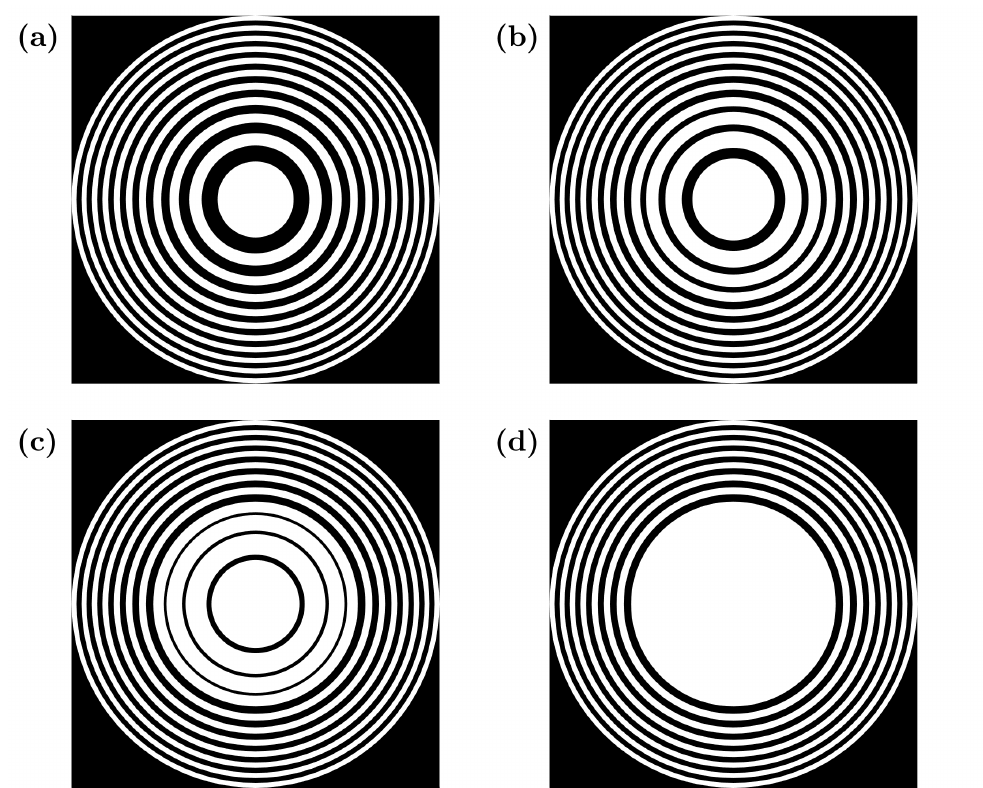
Figure 3. FZP layouts for different predistortion parameters: ( a ) δ = 0, ( b ) δ = 1/3, ( c ) δ = 2/3 and ( d ) δ = 1. Predistortion is applied to L = 7 inner Fresnel